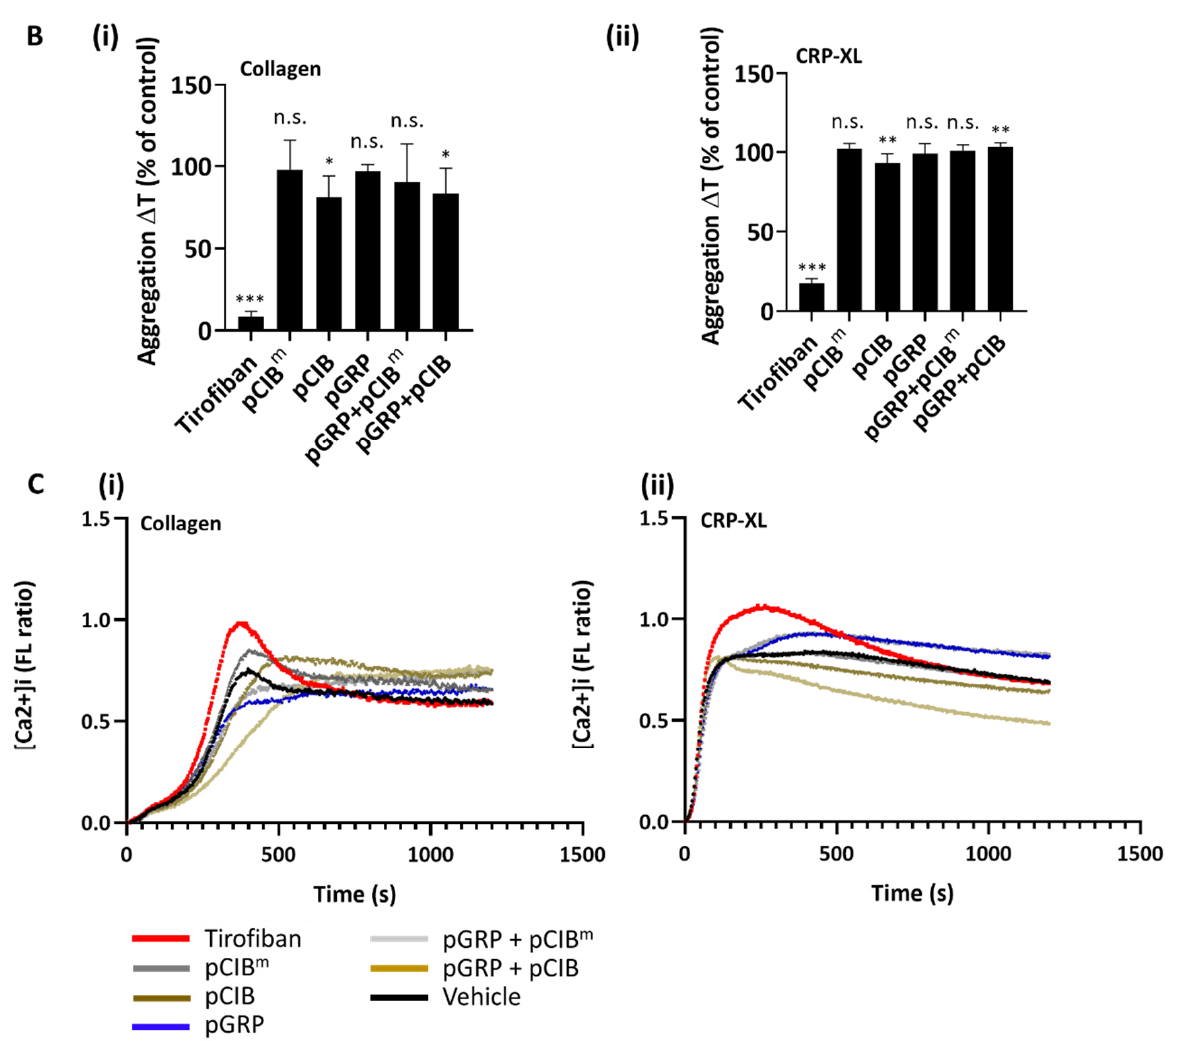
Figure 8. No effect of combined peptides pGRP and pCIB on collagen-induced platelet aggregation or Ca 2+ fluxes. ( A , B ) Platelet preparations (250 × 10 8 /L) were pre-incubated with vehicle control, tirofiban (1 µ g/mL) or indicated peptides (50 µ g/mL) for 10 min. Platelet aggregation was monitored by light transmission aggregometry in response to 1 µ g/mL collagen I or ( i ) or 1 µ g/mL CRP-XL ( ii ). ( A ) representative aggregation traces ( B ) and normalized transmission changes. ( C ) Fura-2-loaded platelets were pre-incubated with vehicle control, tirofiban (1 µ g/mL), or indicated peptides (50 µ g/mL) for 10 min, before addition to 96-well plates. After supplementation of 1 mM CaCl 2 , loaded platelets were automatically stimulated with 10 µ g/mL collagen I ( i ) or 10 µ g/mL CRP-XL ( ii ). Dual wavelength 340/380 nm fluorescence changes per well were recorded in a FlexStation 3. Shown are representative [Ca 2+ ] i traces per agonist. Mean values ± SD (n = 3 donors); n.s., not significant, * p < 0.05, ** p < 0.005, *** p < 0.001, vs. vehicle (paired Student’s t -test).